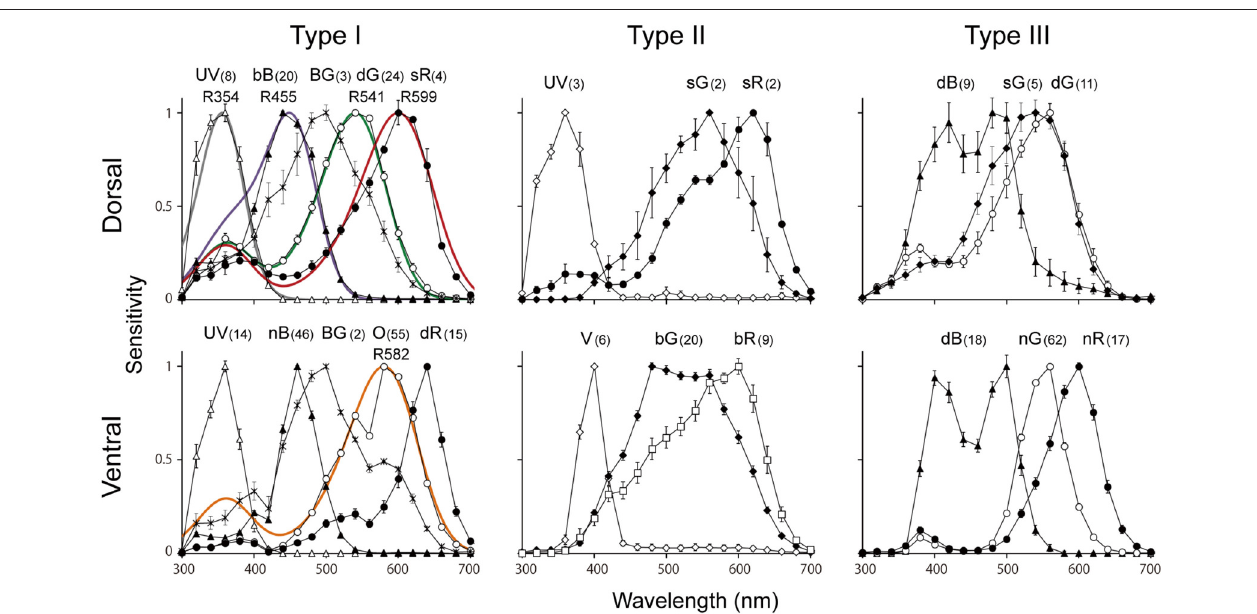
FIGURE 5 | Average spectral sensitivities of photoreceptors (mean ± standard errors) in each type of ommatidium in the male Graphium sarpedon retina. Note that the UV, dB, BG, dG, sG, sR appear more than once in graphs. Numbers appearing with photoreceptor types indicate number of recorded cells that were successfully stained. Colored curves in type I graphs indicate the predicted absorption spectra of visual pigments peaking at 354nm (R354, GsUV), R455 (GsB), R541 (GsL2), R599 (GsL3a), and R582 (GsL3b).